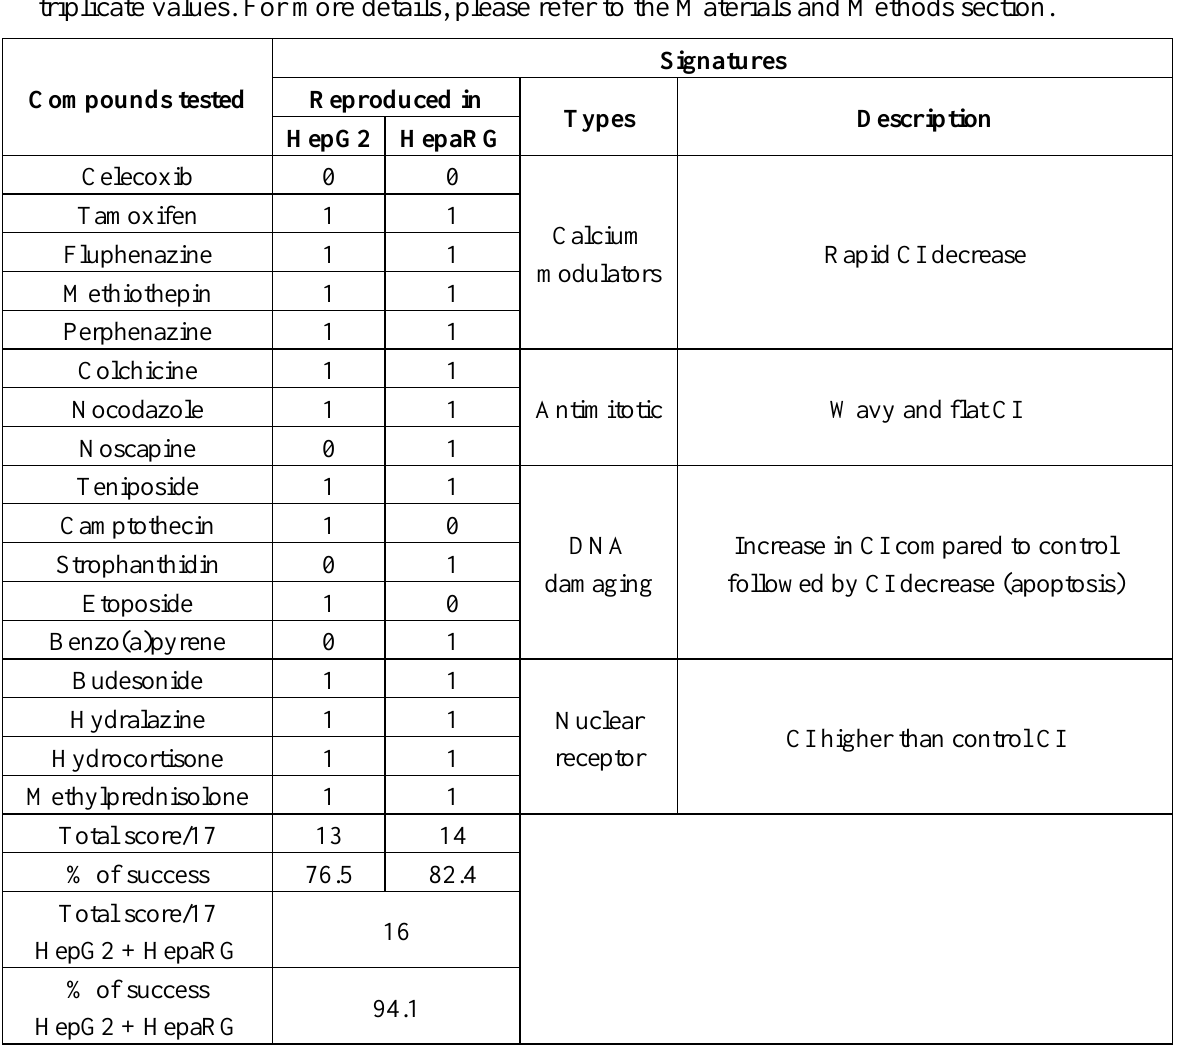
Table 2. Effect of different mechanisms of action on cell index curves (RTCA) generated in HepG2 and fresh HepaRG cells. Three to five compounds known to be either calcium modulators, antimitotics agents, DNA damaging compounds or nuclear receptor agents were evaluated per category. A score of 0 or 1 was given when the RTCA profiles generated were comparable or not to those generated in the paper of Abassi et al.